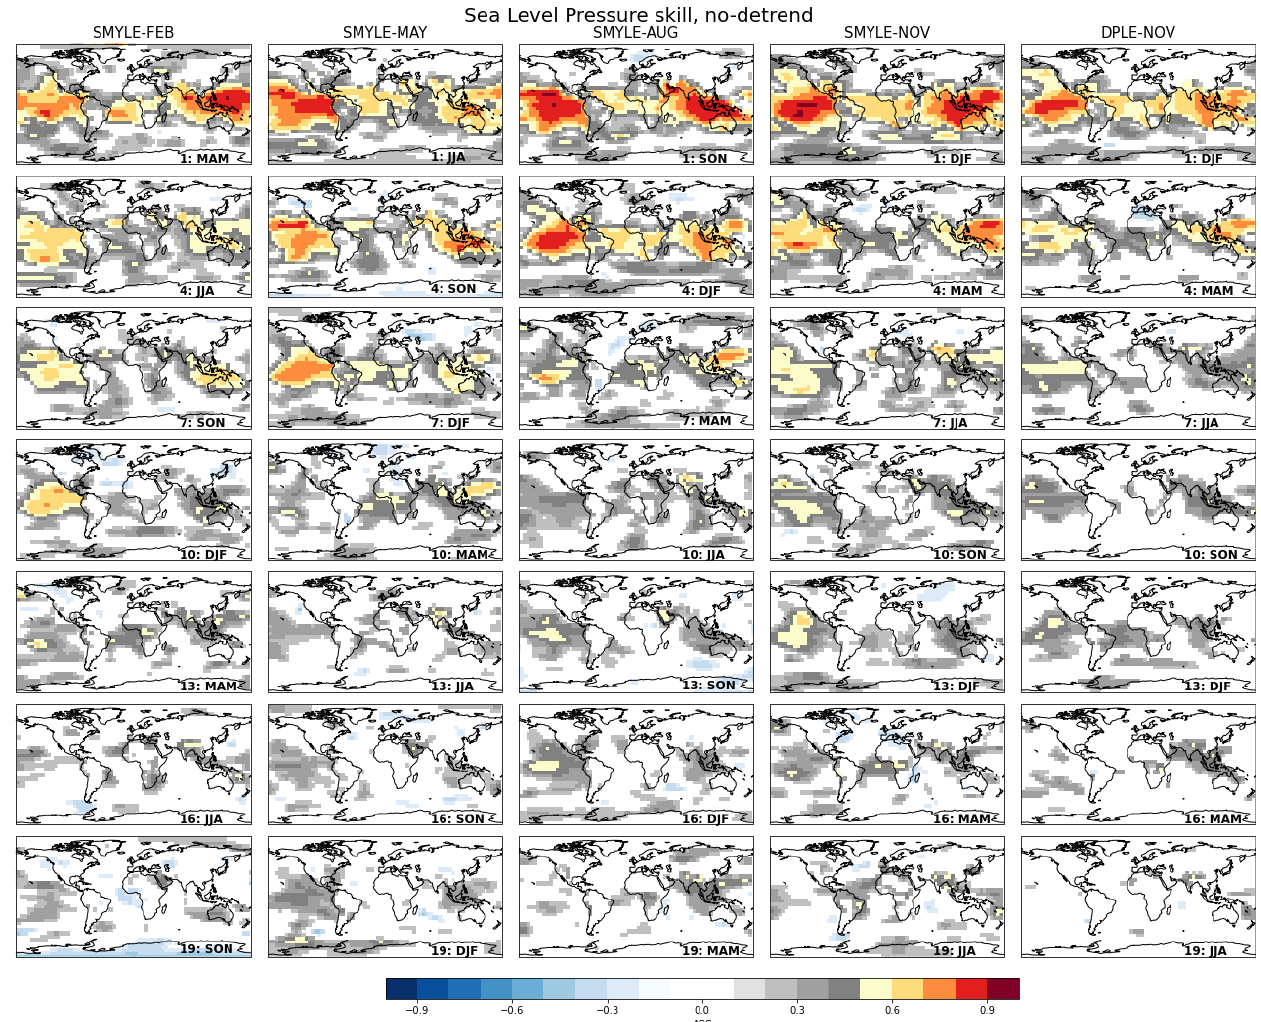
Figure B5. Equivalent to Fig. 6 (sea level pressure ACC) but without removing a linear trend.